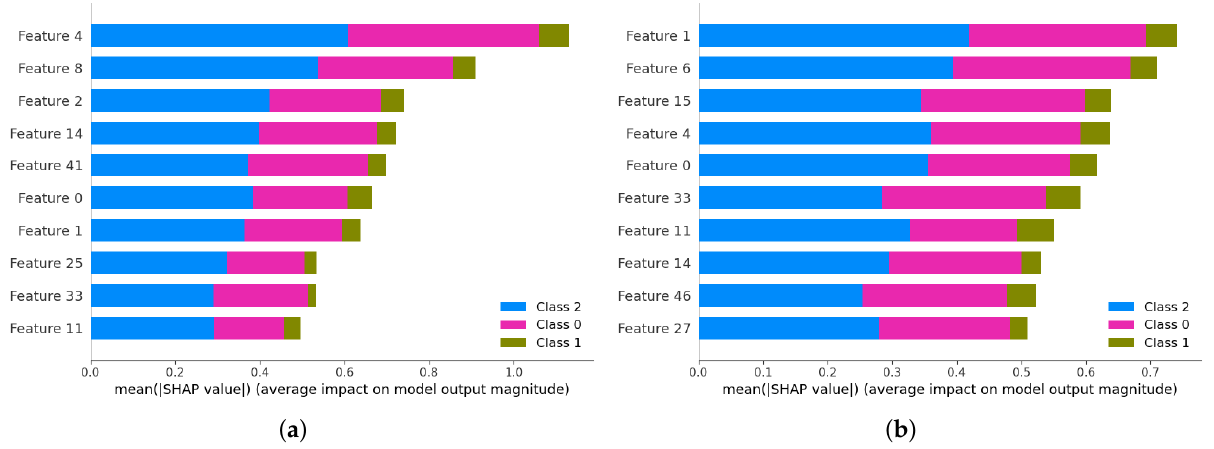
Figure 7. Illustrating ( a ) 10 features with the highest contribution in the feature representation learned by Encoder1 and ( b ) 10 features with the highest contribution in the feature representation learned by